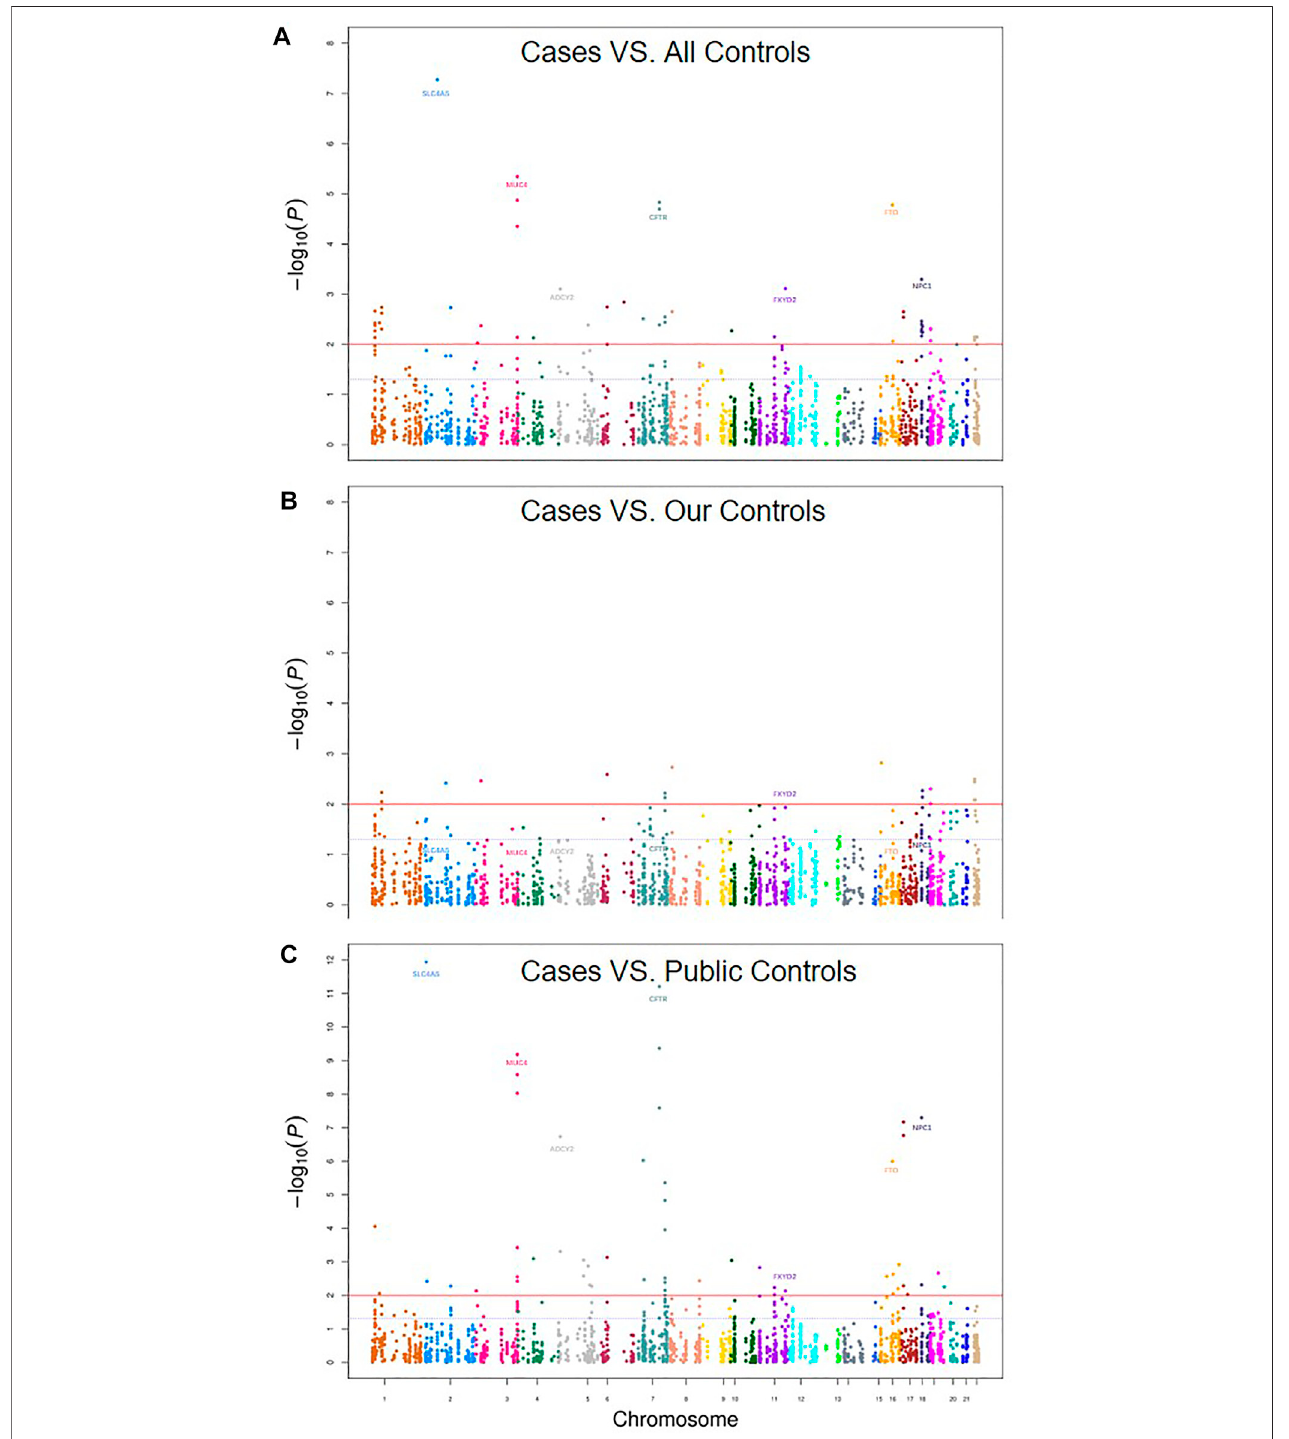
FIGURE3 | Manhattan Plot ofgallstonesfor (A) Cases vs. all controls (our 52 controls +41public controls), (B) Cases. our 52controlsand (C) Cases vs. 41public controls. The plot shows − log 10 p value for each SNP against the chromosomal location. The x -axis represents chromosomal position and the y -axis shows − log 10 p values. The blue dashed line indicates the p value of 0.05 while the solid red line indicates the p value of 0.01.